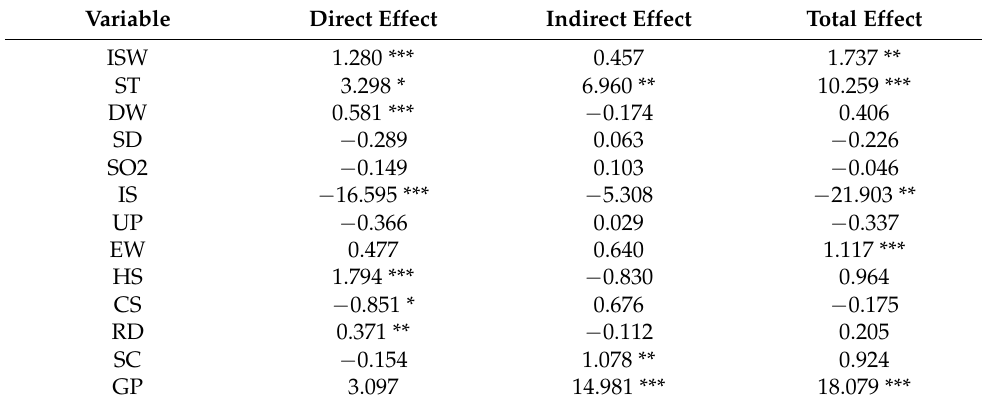
Table 7. Decomposition results from spatial